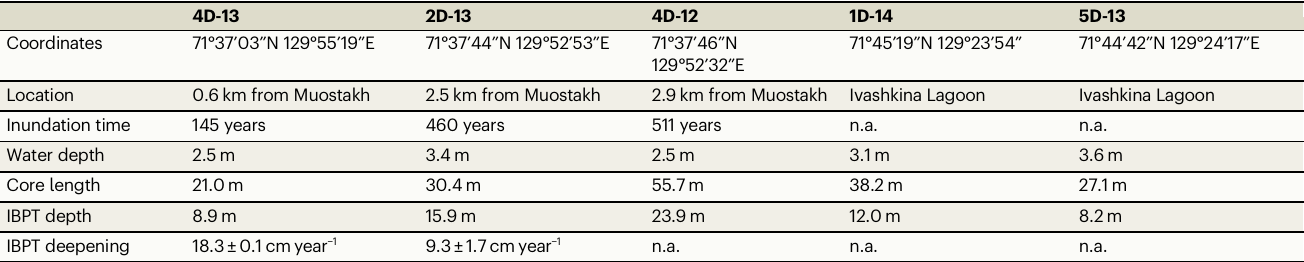
Table 1 | Overview of the subsea permafrost drill cores 4D-13, 2D-13, 4D-12, 1D-14, and 5D-13 from the Buor-Khaya Bay, drilled near Muostakh Island and in Ivashkina